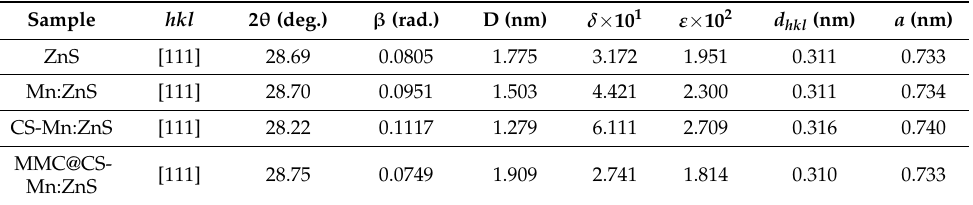
Table 2. Table 2. Variation of different structural parameters of different types of NPs.